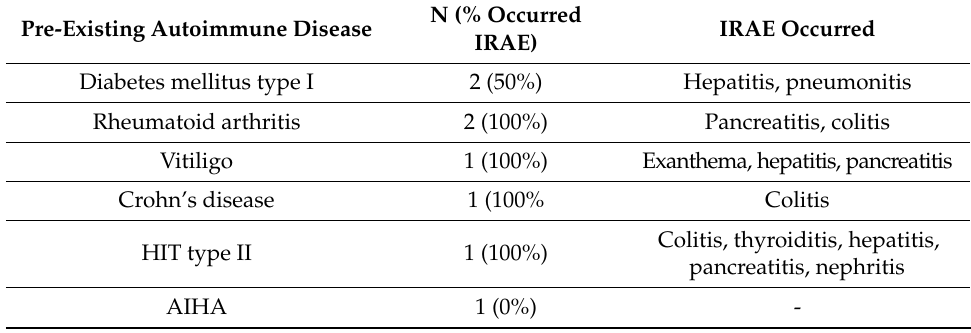
Table 4. IRAE occurrence in patients with pre-existing autoimmune